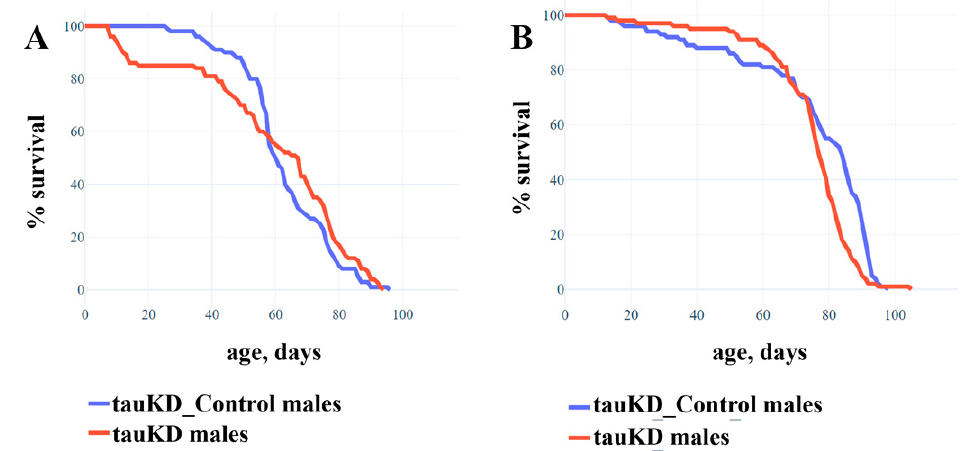
Figure 3. Decreased expression of the tau gene has no effect on the lifespan of males and females. ( A )—Experiment with males. ( B )—Experiment with females. A detailed description of the geno- types is given in the Materials and Methods section. Statistical analysis of the data is given in the Supplementary Materials Table S3.